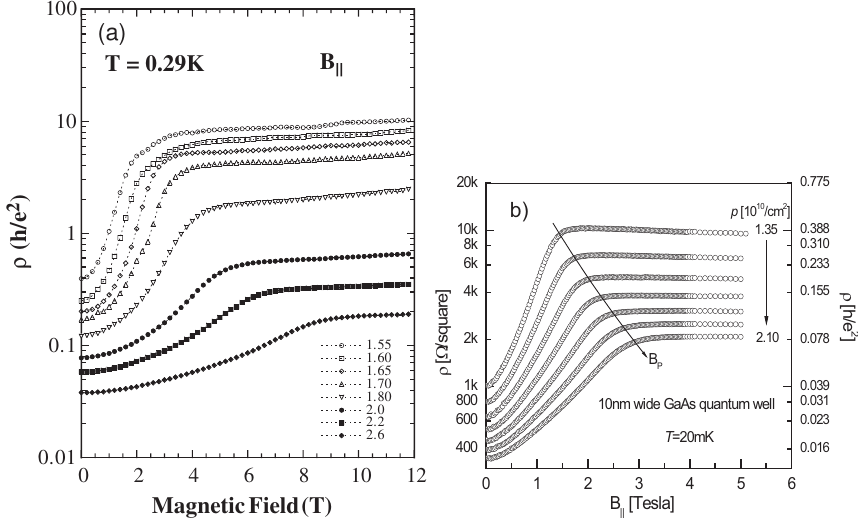
Figure 2. ( a ) Resistivity vs. parallel magnetic field measured at T = 0.29 K in a Si MOSFET. Densities are indicated in units of 10 11 cm − 2 ; from [20]. ( b ) Resistivity as a function of B (cid:107) in a 10 nm-wide p -type GaAs quantum well at 20 mK; from [21].